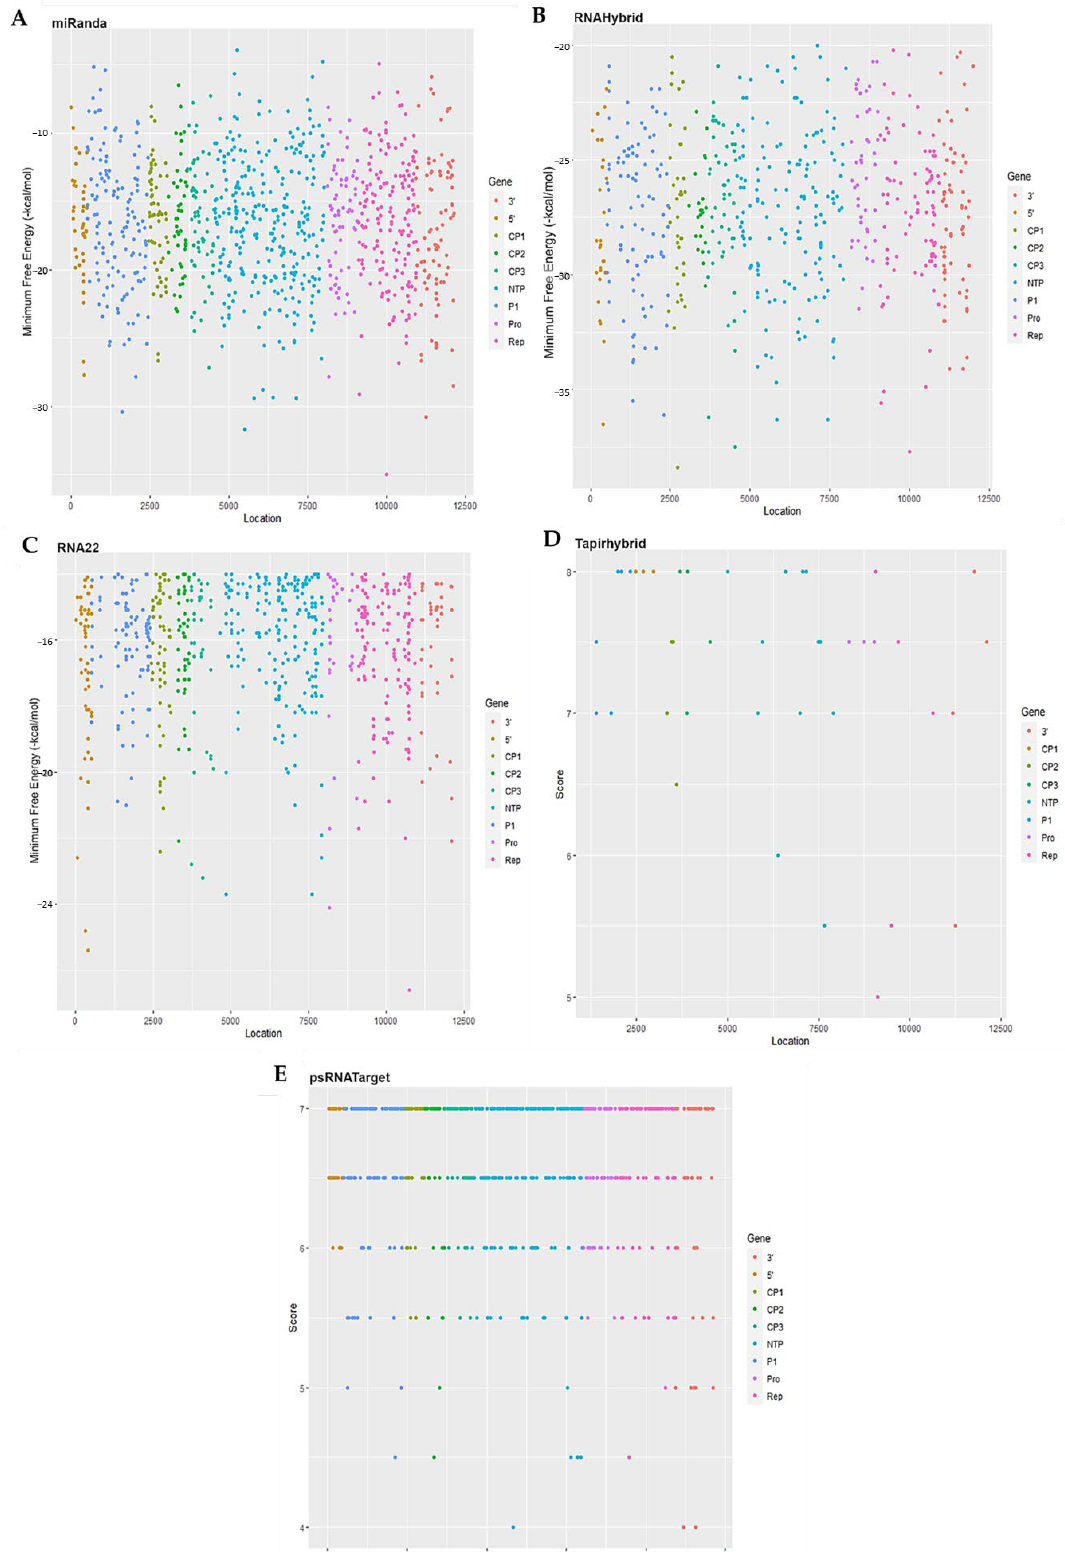
Figure 4. miRNA target site prediction outcome of rice’s miRNA on the RTSV’s genome sequence using the algorithms of miRanda ( A ), RNAhybrid ( B ), RNA22 ( C ), Tapirhybrid ( D ), psRNATarget ( E ). The colour key represents the respective regions in the genome.